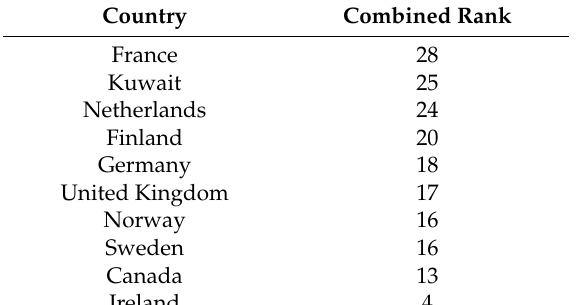
Table 2. Bottom 10 countries with lowest combined rank (shown in green on Figure2).